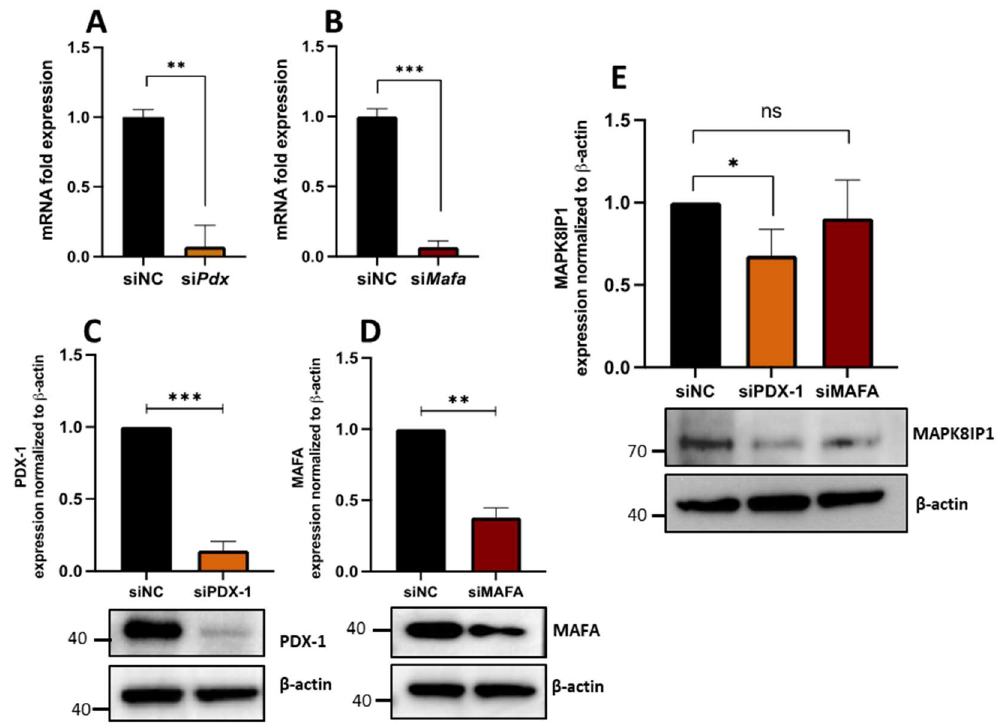
Figure 5. Impact of Pdx1 and MafA silencing on the expression of MAPK8IP1 in INS-1 cells. Cells were transfected with siRNA against Pdx1 ( siPdx1 ) or MafA (si MafA), or the siRNA negative control (siNC). ( A ) Silencing efficiency of Pdx1 in INS1 cells 48 h post-transfection as measured by qRT- PCR. ( B ) Silencing efficiency of MafA in INS1 cells 48 h post-transfection as measured by qRT-PCR qPCR. ( C – E ) Western blot analysis of PDX1 ( C ), MAFA ( D ) and MAPK8IP1 ( E ) in Pdx1 or MafA - silenced cells and control cells relative to the endogenous control protein β -actin (lower panels). Corresponding fold changes in the intensities of the Western blot bands are shown above each blot. Data were obtained from three independent experiments (see Supplementary Figures S5–S7). * p < 0.05, ** p < 0.01, *** p < 0.001, ns; not significant. Bars above histograms represent SD of the